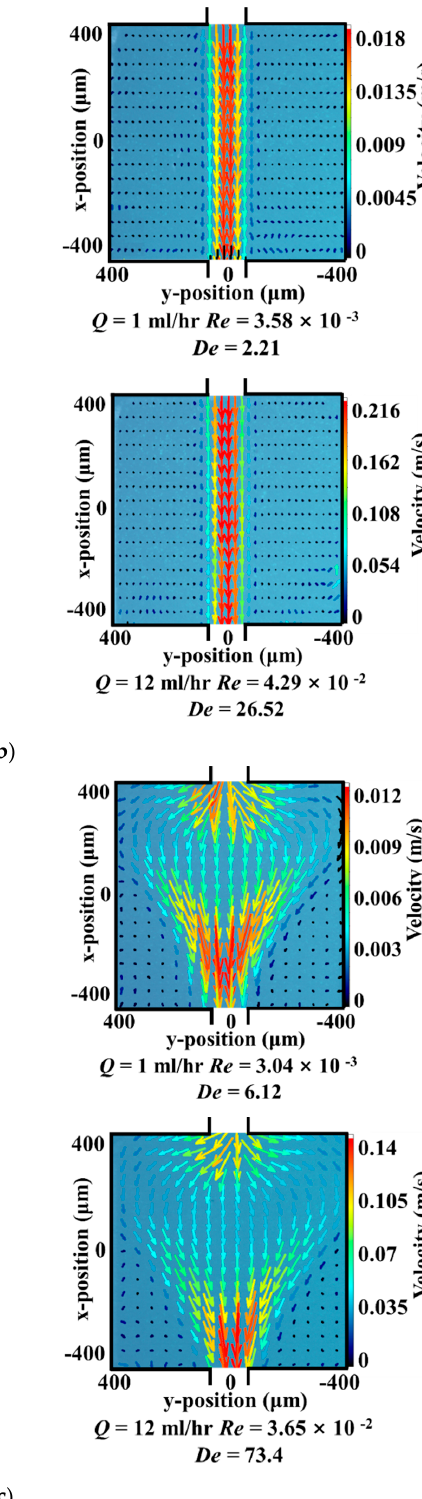
Figure 4. The development of flow patterns for the flow of ( a ) Newtonian fluid, ( b ) HPAM solution and ( c ) VES fluid in long pore-throat structure, flow rates range from 0.5 mL/h to12 mL/h.